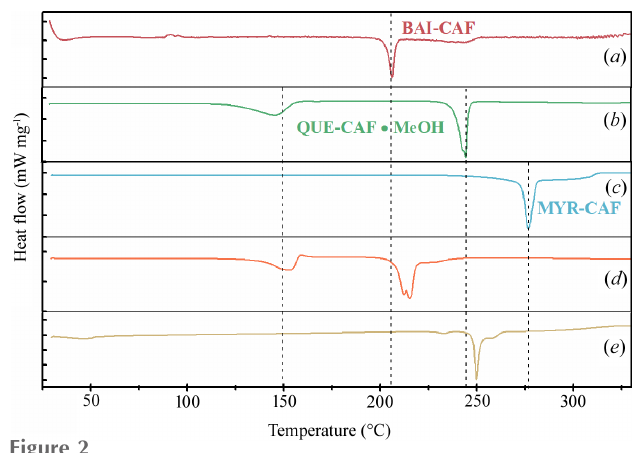
Figure 2 DSC profiles of the cocrystals ( a ) BAI–CAF, ( b ) QUE–CAF (cid:9) MeOH, ( c ) MYR–CAF) and competitive systems ( d ) BQC, ( e ) QMC.